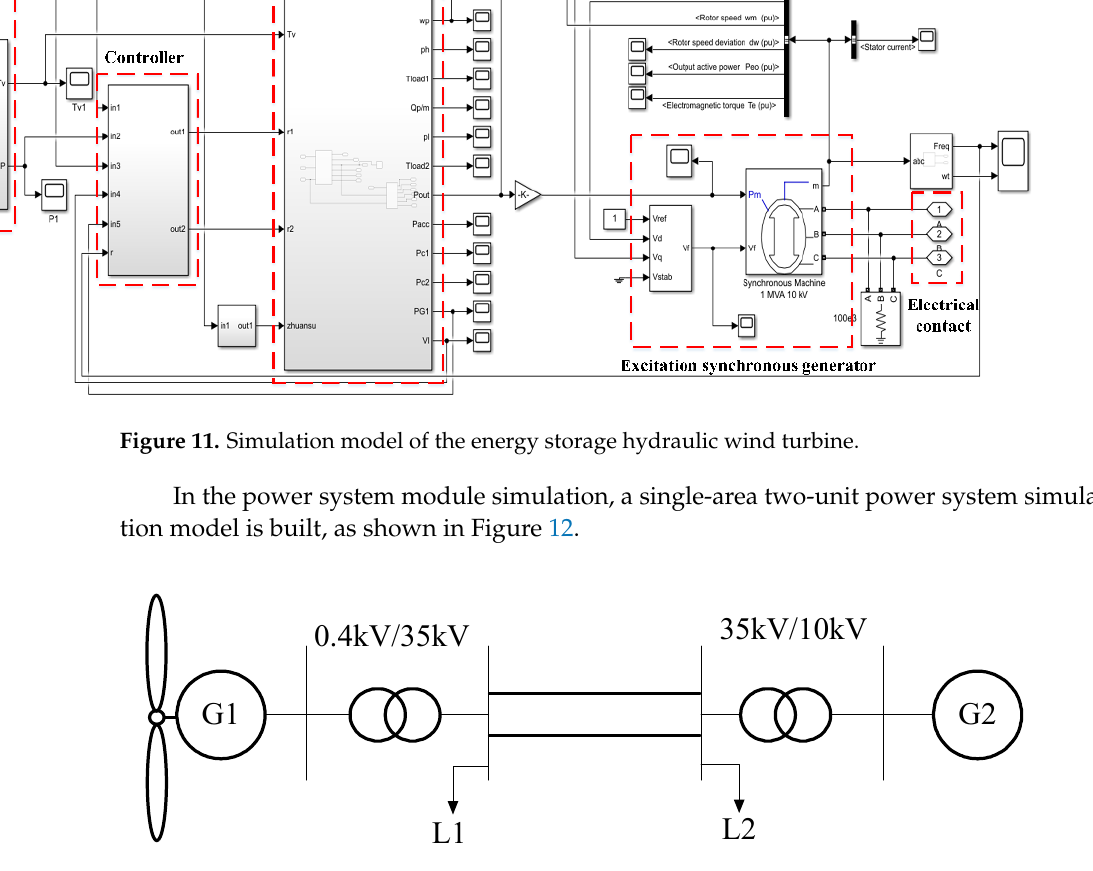
Figure 12. Single area with a two-unit power system model.